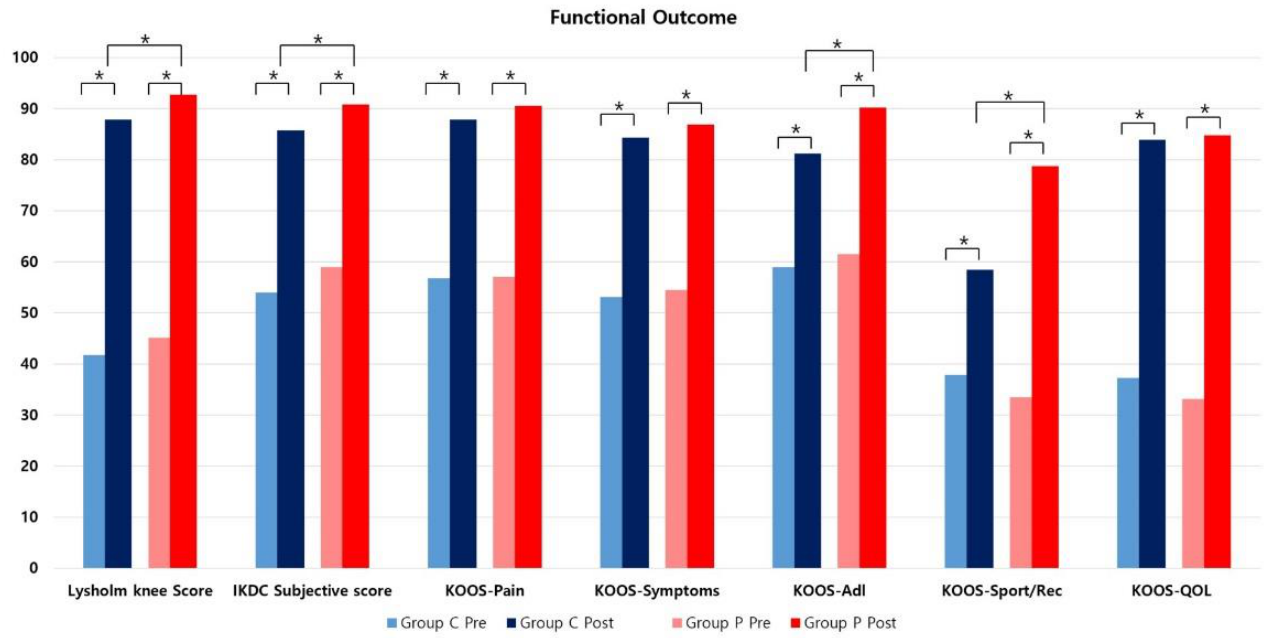
Figure 4. Comparison of functional outcomes for preoperative and postoperative values within groups and postoperative values between the groups. * p < 0.05.